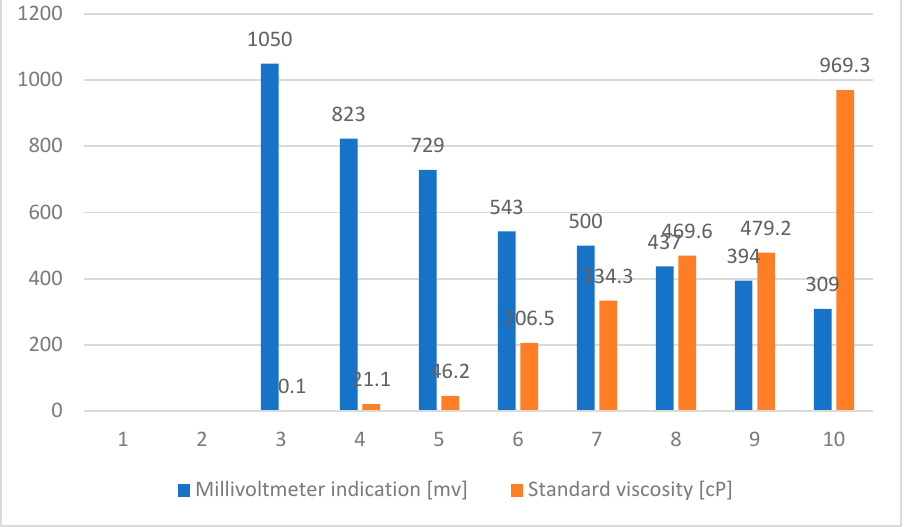
Figure 7. Calibration values for viscosity.